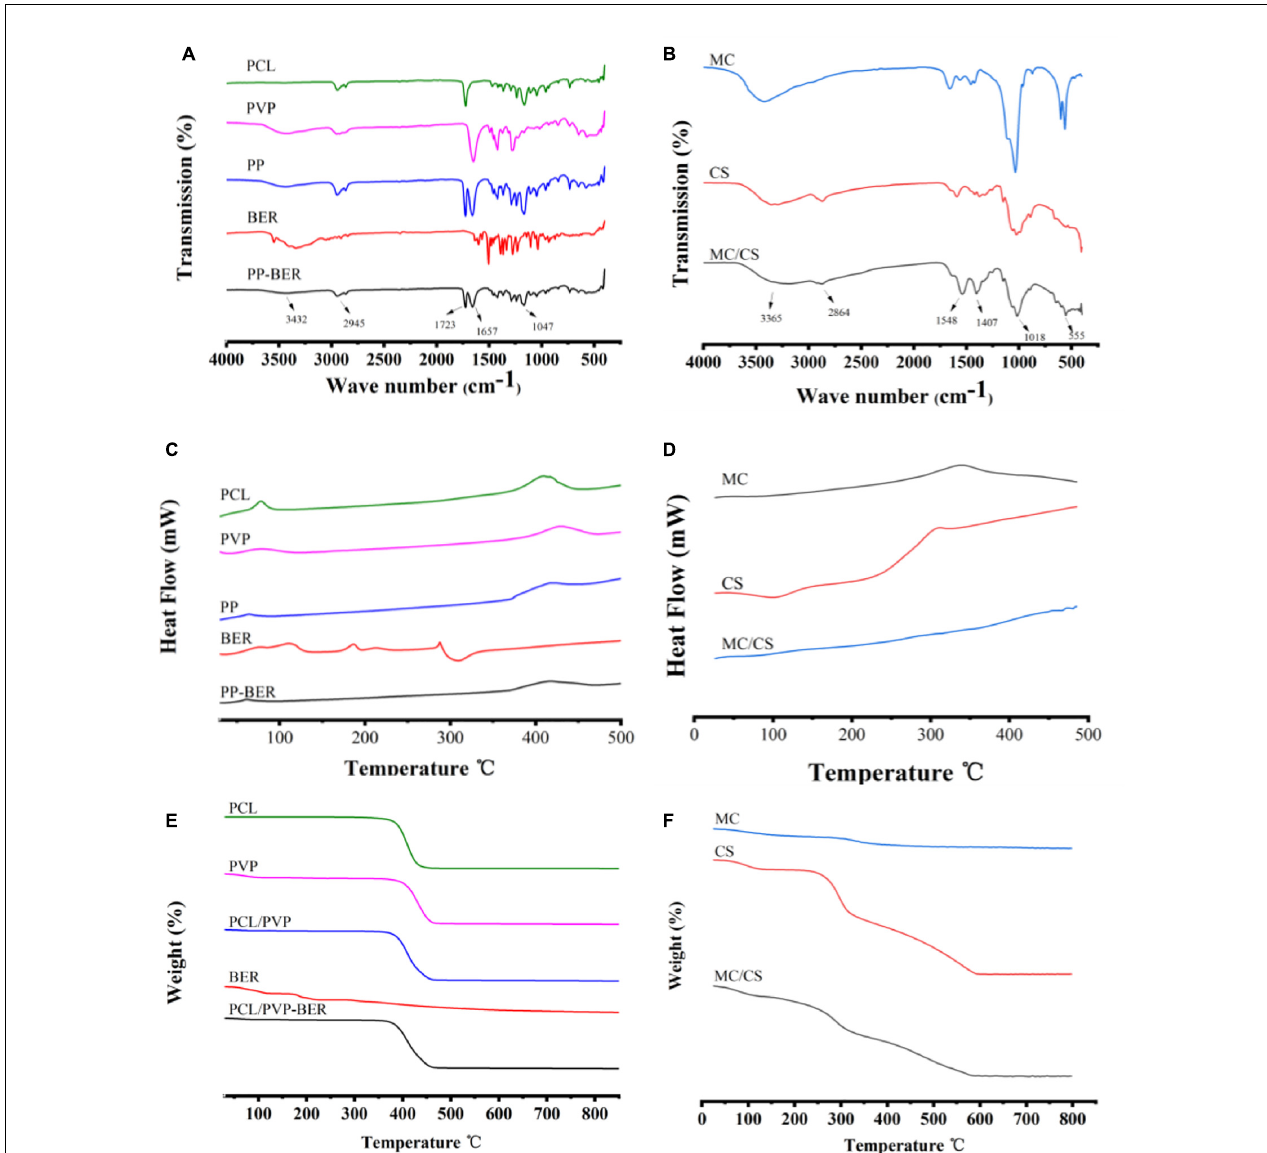
FIGURE 3 | (A,B) FT-IR spectra of PCL, PVP, PCL/PVP electrospun nanofibers (PP), BER, and BER@PCL/PVP electrospun nanofibers (PP-BER) (A) ; and MC, CS, and MC/CS cast film (B) . (C,D) . DSC curves of PCL, PVP, PP, BER, and PP-BER (C) ; and MC, CS, and MC/CS cast film (D) . (E,F) . TGA curves of PCL, PVP, PP, BER, and PP-BER (E) ; and MC, CS, and MC/CS cast film (F)